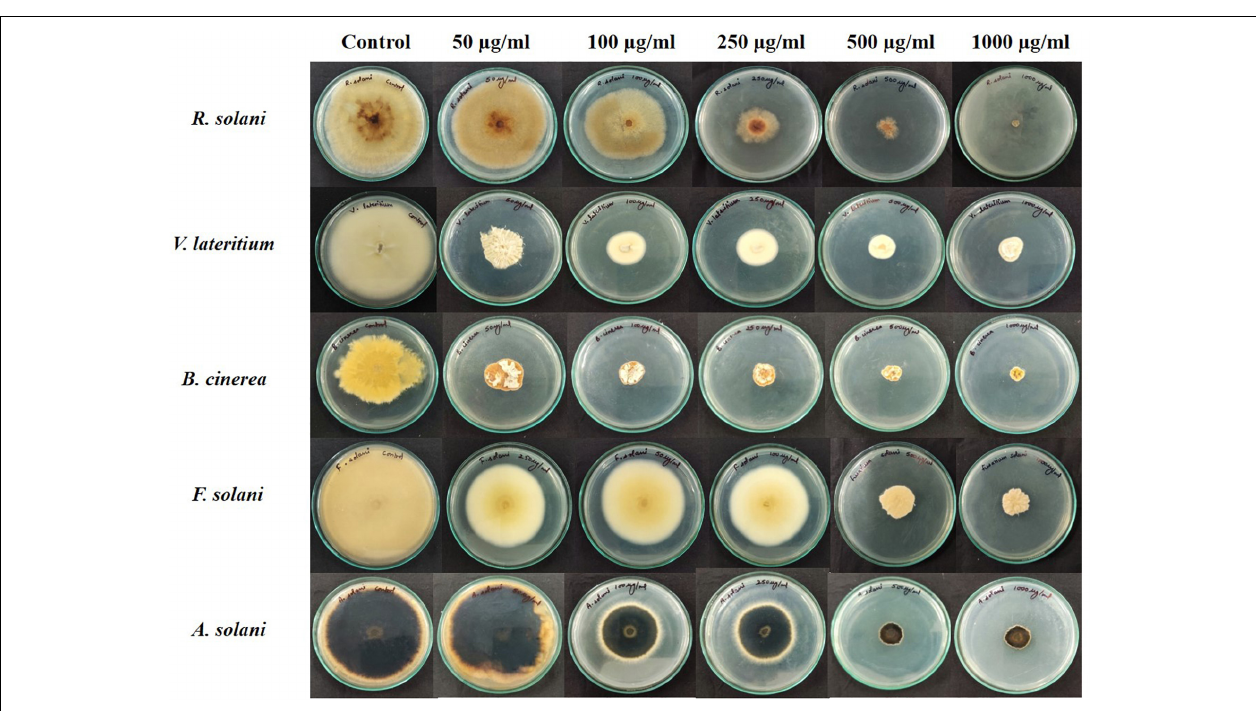
FIGURE 6 | Antifungal bioassay of lipopeptide extracted from Bacillus siamensis strain NKIT9 at 5 different concentrations of 50, 100, 250, 500, and 1000 µ g/ml against five test pathogenic fungi ( R. solani, F. solani, B. cinerea, A. solani , and V. lateritium).